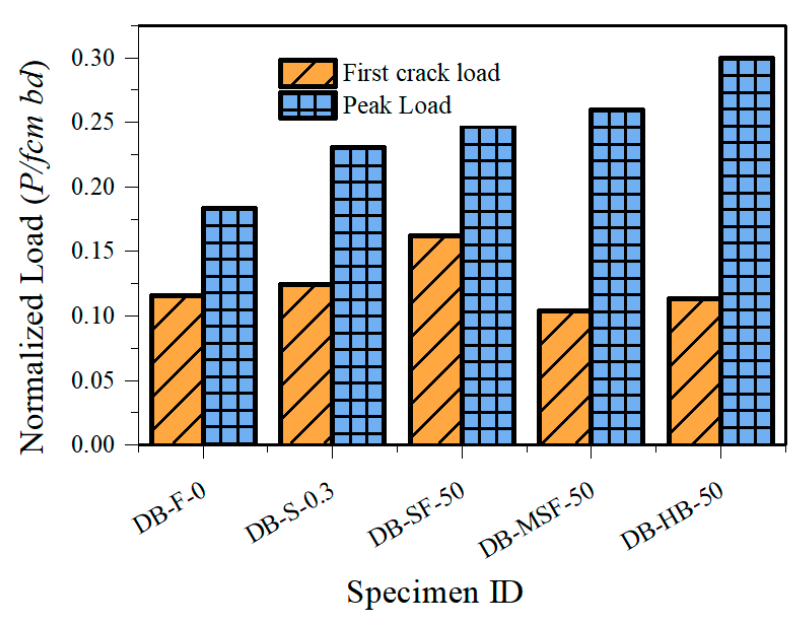
Figure 10. Comparison of first crack and peak load after normalization with f cm bd.